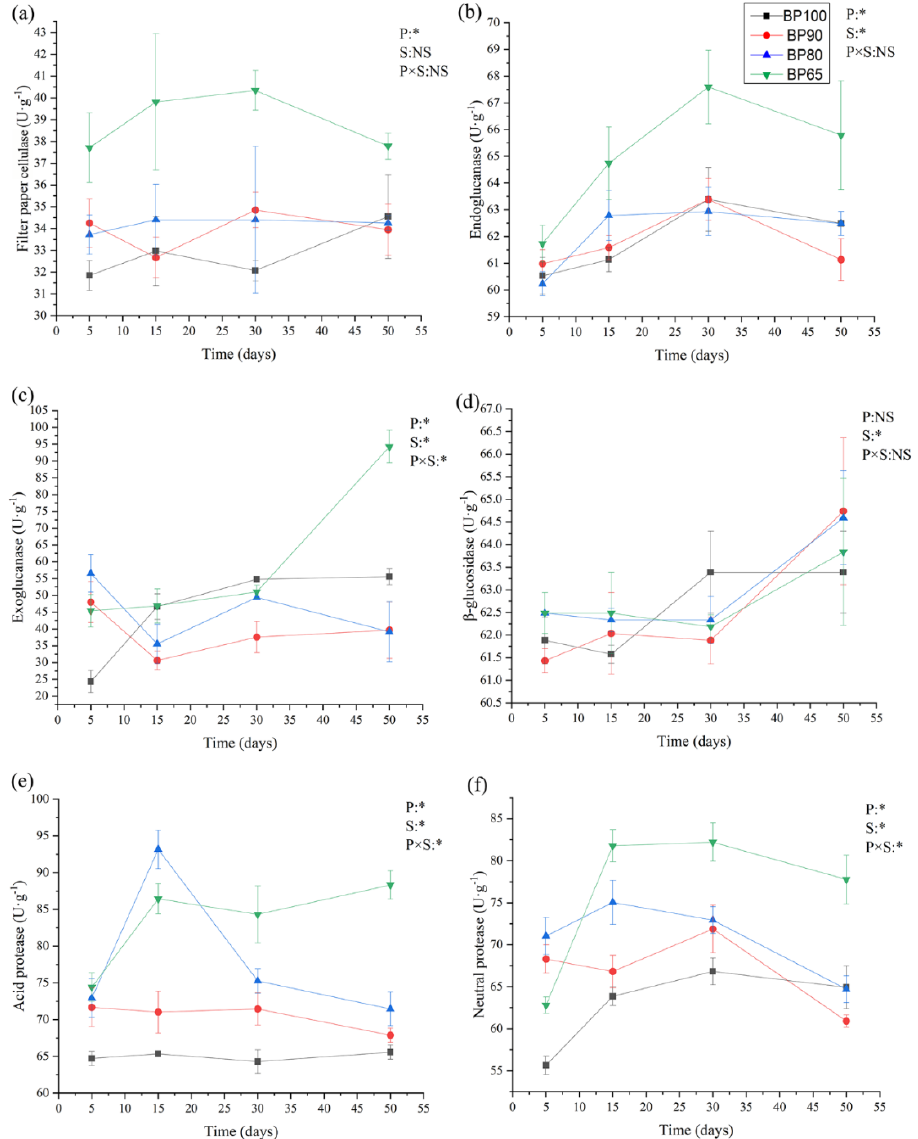
Figure 2. Dynamics of enzyme activities including ( a ) filter paper cellulase, ( b ) endoglucanase, ( c ) exoglucanase, ( d ) β -glucosidase, ( e ) acid protease, and ( f ) neutral protease during silage fermenta- tion. RMANOVA results were reported. P: mixing proportion; S: sampling time; NS, not significant ( p < 0.05); * p < 0.05.